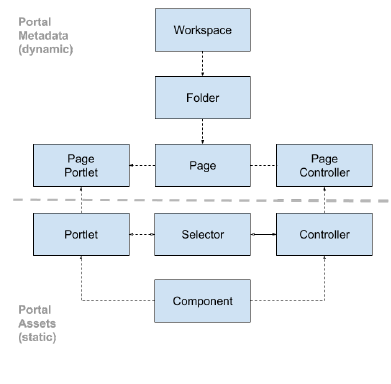
Figure 1. Major persistent objects of presentation